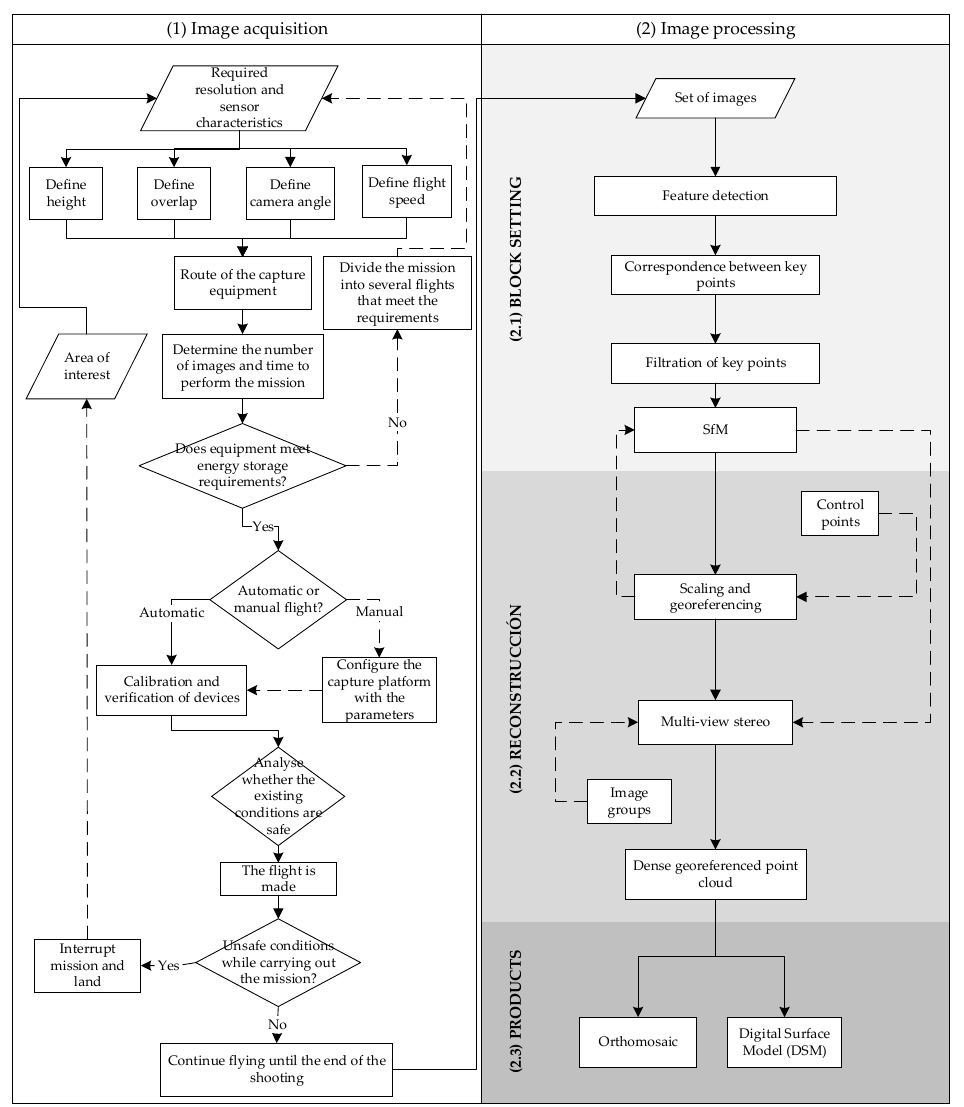
Figure 2. Workflow for the acquisition and processing under the SfM–MVS approach.